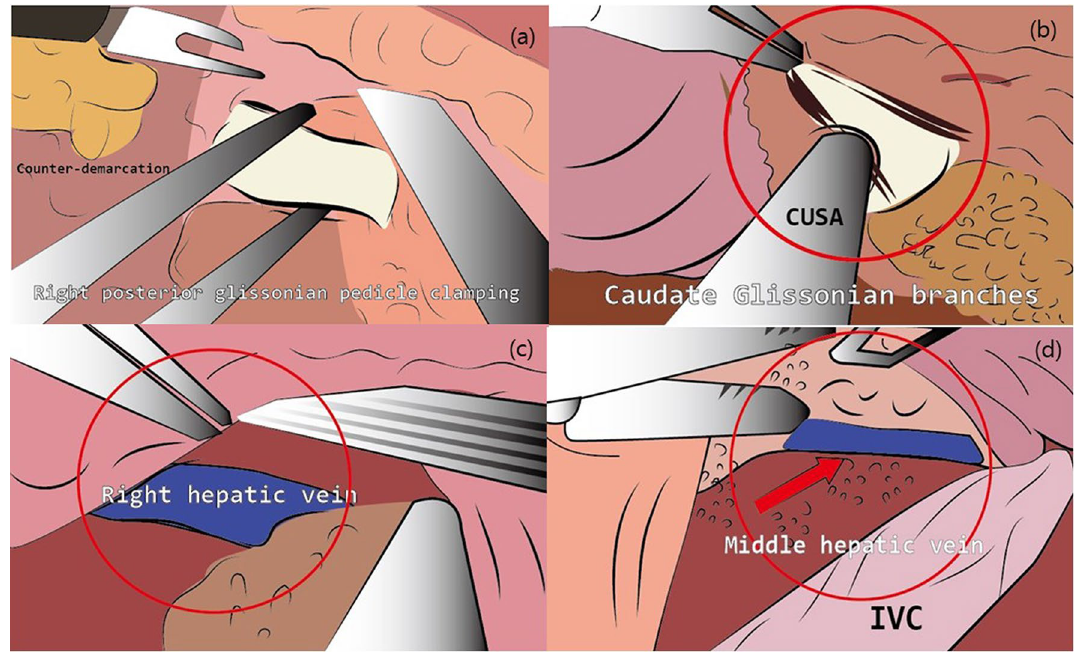
Figure 2. Technical aspect of laparoscopic caudate lobectomy. ( a ) The right posterior glissonian pedicle was isolated and temporarily clamped. ( b ) The caudate glissonian branches were identified and controlled. ( c ) The exposure of right hepatic vein. ( d ) After complete resection of caudate lobe, the exposure of middle hepatic vein.